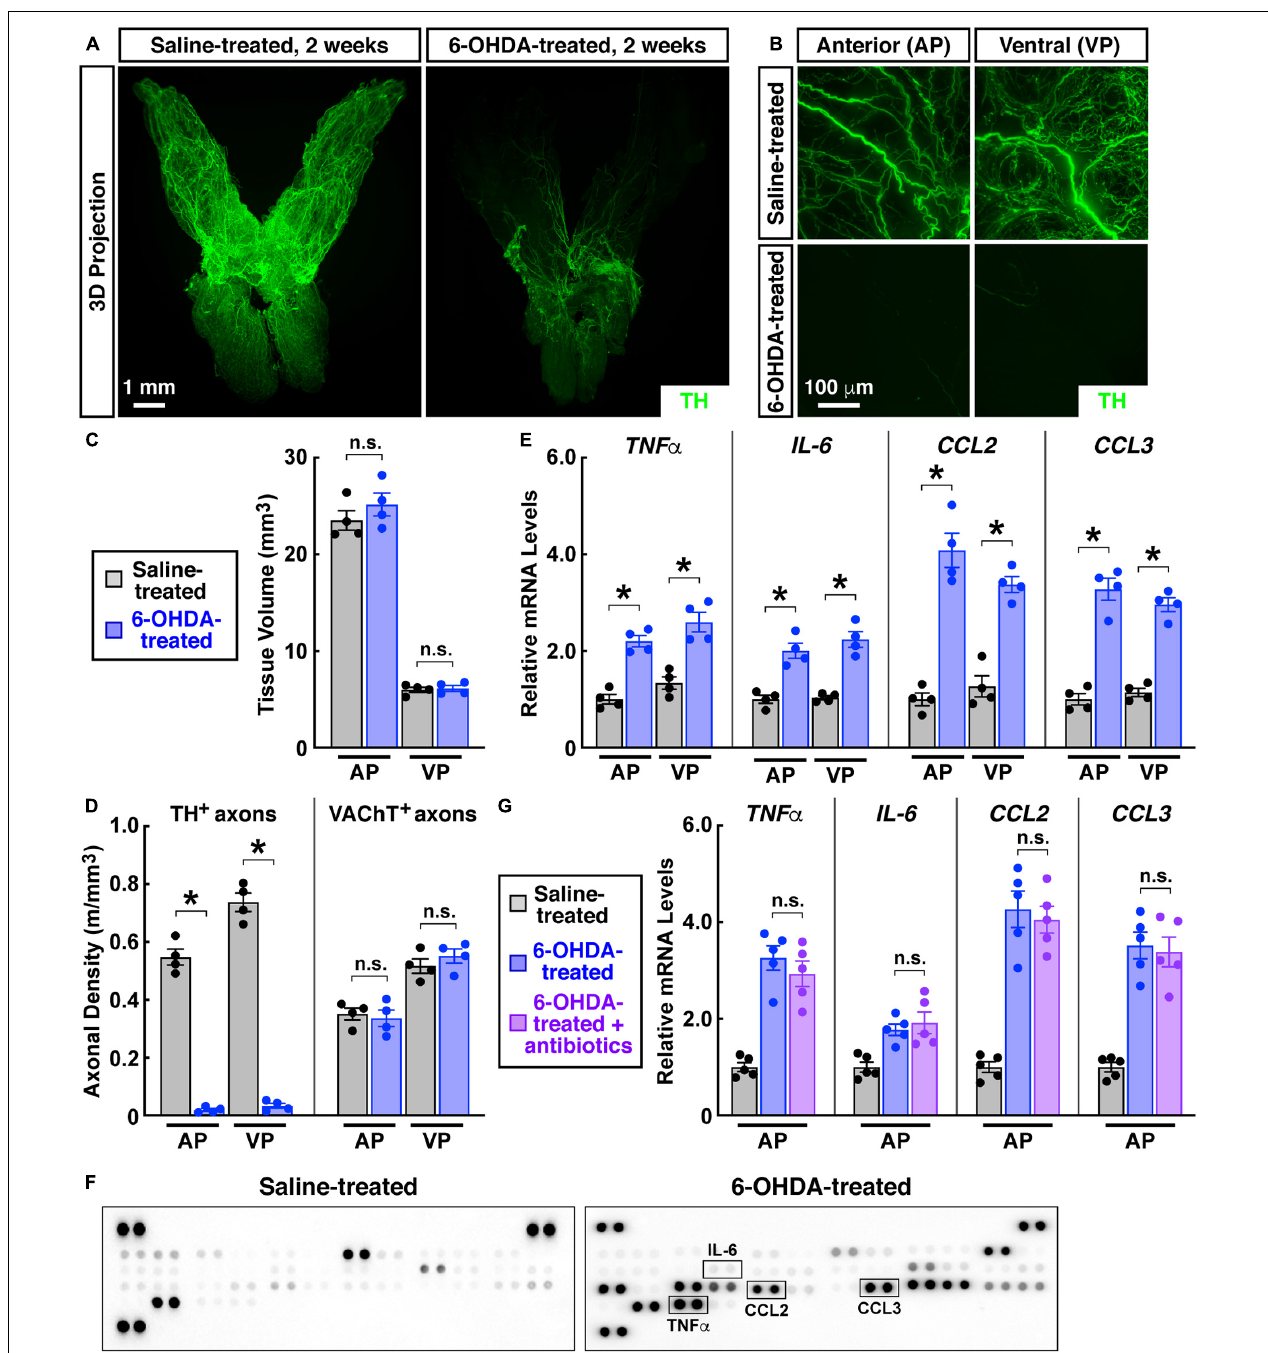
FIGURE 4 | Pharmacologic destruction of sympathetic innervations in the mouse prostate caused sterile inflammation. Eight-week-old male mice were intraperitoneally treated with 6-hydroxydopamine or saline, and the prostates were harvested 2 weeks after the treatment. (A,B) The intact prostates were subjected to the whole-tissue TH-immunolabeling. (A) Representative 3D projections of the lightsheet imaging are shown. (B) Representative 3D projections of the 1-mm thickness of the anterior (AP) and ventral prostate (VP) of the lightsheet imaging are shown. (C) Tissue volumes of the anterior (AP) and ventral prostate (VP) of the saline-treated or 6-OHDA-treated mice were quantified. n = 4, mean ± SEM, n.s., not significant (two-way ANOVA test). (D) TH-positive sympathetic axons or VAChT-positive parasympathetic axons in the anterior (AP) and ventral prostate (VP) were quantified. n = 4, mean ± SEM, * p < 0.05, n.s., not significant (two-way ANOVA test). (E) mRNA levels of pro-inflammatory cytokines and chemokines in the anterior (AP) and ventral prostate (VP) were analyzed by the qPCR analysis. n = 4, mean ± SEM, * p < 0.05 (two-way ANOVA test). (F) Cytokines and chemokines in the anterior prostate were analyzed by the mouse cytokine array. (G) The mice at 2 weeks after the 6-OHDA treatment were daily treated by antibiotics via intraperitoneal injection for 5 days. mRNA levels of pro-inflammatory cytokines and chemokines in the anterior prostate (AP) were determined by the qPCR analysis. n = 5, mean ± SEM, n.s., not significant (one-way ANOVA test).